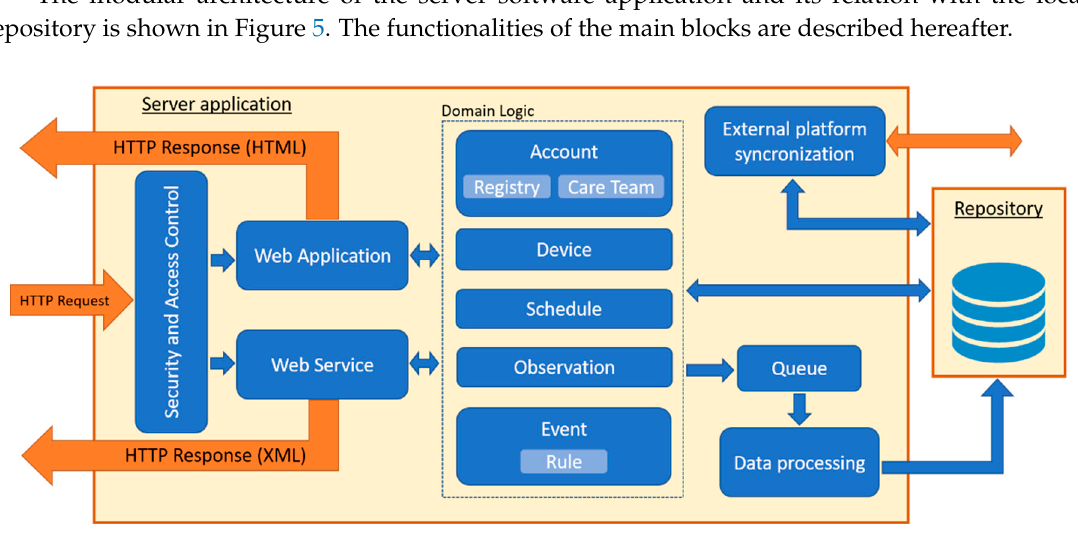
Figure 5. Architecture of the server software application and repository.